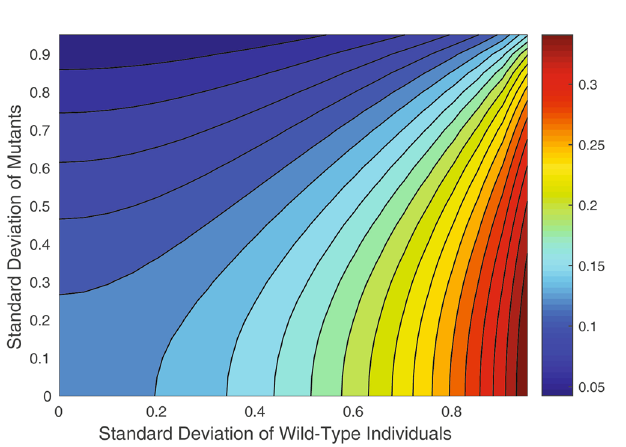
Figure 4. The function 〈 P N 〉 N in terms of the skewness ( N = 4, death–birthMoranprocess). We assume that the mean fitness of the mutants is equal to that of the wild types, and σ σ =  . As before, 〈 P N 〉 N greater that unity indicates that the mutants experience selective advantage; the effect is the largest for the largest negative skewness.